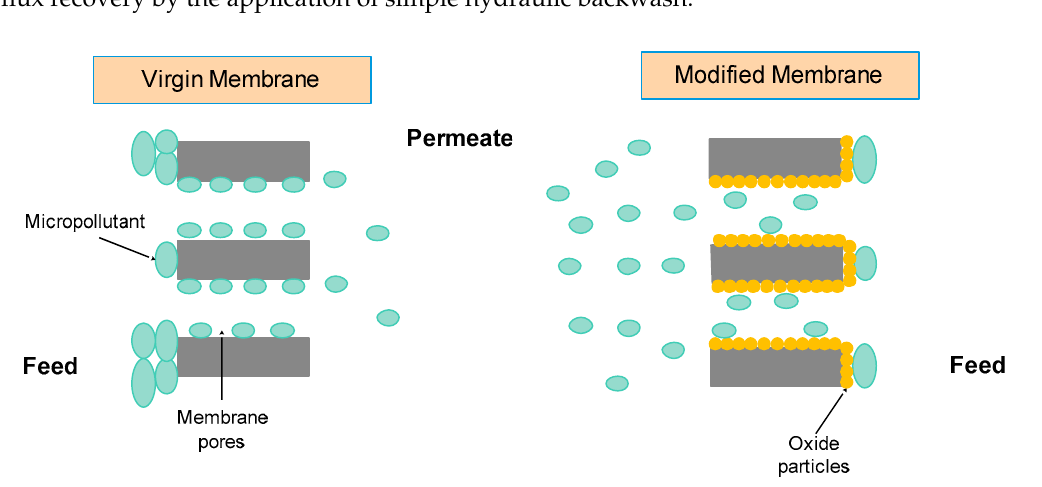
Figure 6. The influence of oxide presence in membrane fouling (Adapted from [26]).